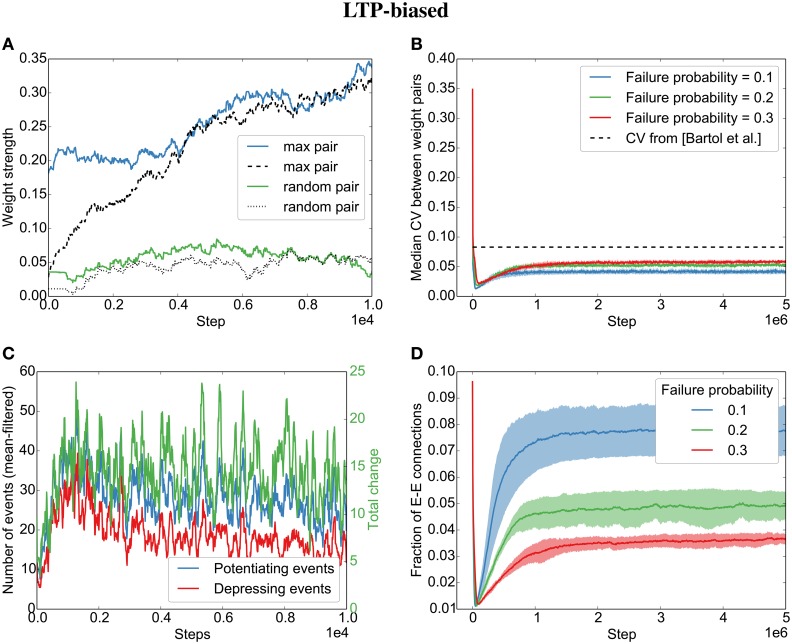
Parallel synapses align in recurrent circuits with LTP-biased STDP. The SORN model was simulated with 20% failure probability for each synapse and potentiation 1.25 times as strong as depression. (A) Parallel synapses align. The pair with the maximal final mean weight (blue and dashed) and a randomly selected pair (green and dotted) are plotted for the beginning of the simulation. (B) The divergence measured by the coefficient of variation (CV) drops below the experimentally reported values for different failure probabilities. (C) STDP dynamics at the beginning of the simulation. There are fewer depressing events (red line) than potentiating events (blue line) and the total weight change due to STDP is positive (green line). (D) The overall fraction of excitatory-to-excitatory connections converges and follows a qualitatively similarly fast decay and slow increase as reported in the original paper (Zheng et al., 2013) for different failure probabilities. Shaded areas are standard deviations over five independent simulations.